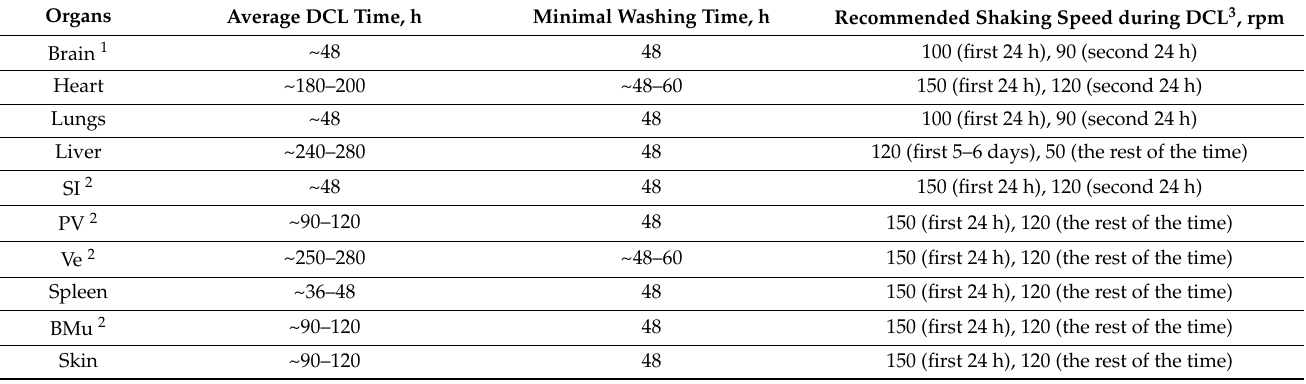
Table A1. Recommended protocols of iWO-DCL of ED18 chick embryo organs and